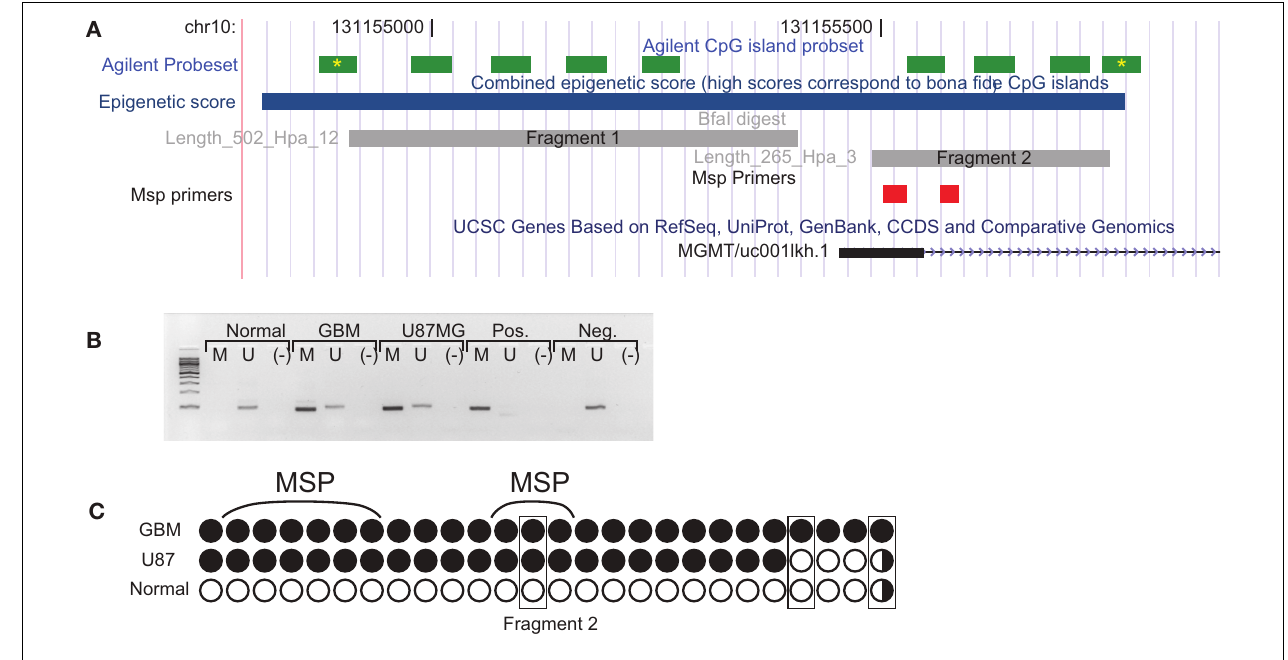
FIGURE 7 | BfaI fragment coverage of the MGMT CpG island and bisulfi te validation. (A) UCSC browser representation of MGMT CpG island showing two MSRE sensitive fragments in gray, predicted CpG island in blue, Agilent probes in green (note partial binding probes *), and methylation-specifi c PCR primers in red. Fragment 1 is 502 bp and contains 12 CCGG sites. Fragment 2 is 265 bp and contains 3 CCGG sites and binds MSP primers. Fragment 2 contains a portion of exon 1. (B) MSP results of human DNA samples confi rm bisulfi te sequencing with normal brain showing an unmethylated band, and GBM and